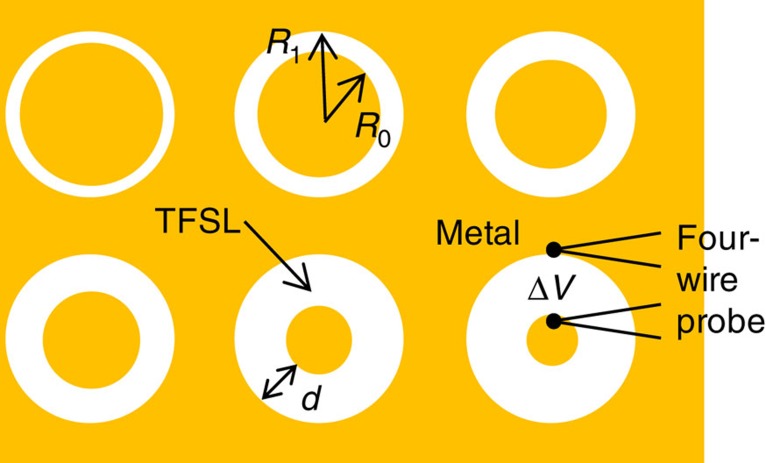
Example of circular TLM patterns used for contact resistivity determination.In this measurement technique, six gaps of increasing widths (d=R1−R0) are patterned onto the sample surface. The gold colour represents the metal contact, while the white is the thin-film superlattice (TFSL) surface. A four-wire probe is used to apply a small current across each gap and measure the voltage drop (ΔV).